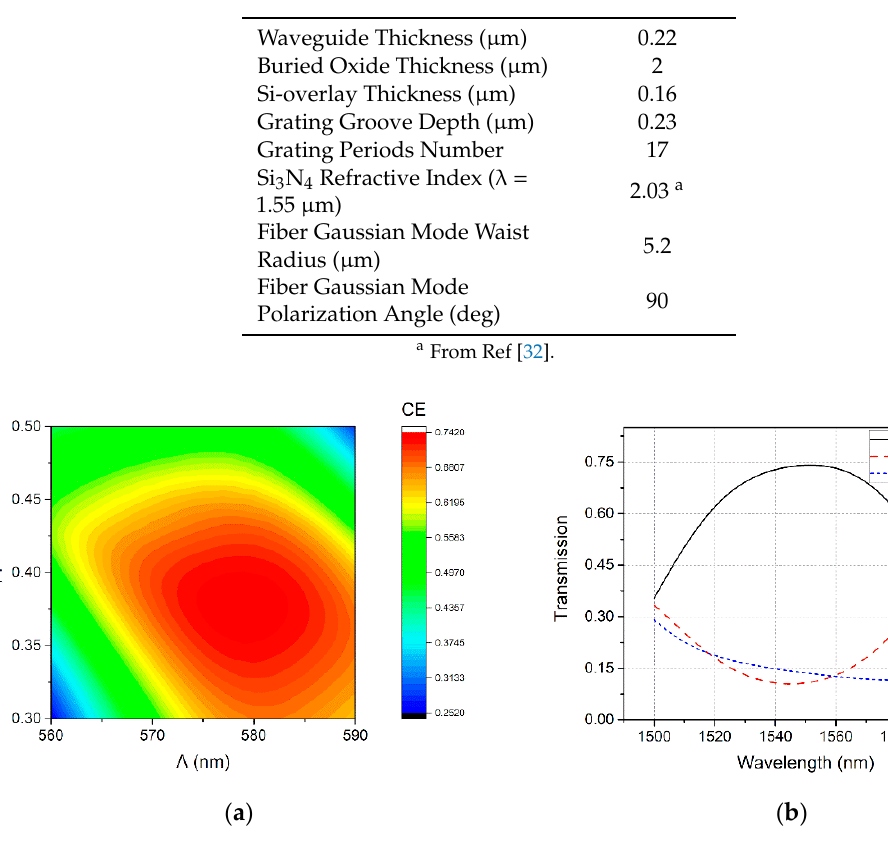
Figure 3. ( a ) The CE at 1550 nm with different Λ and filling factor (FF). The grating coupler with Λ = 578 nm and FF = 0.38 achieves CE of 74%. ( b ) Calculated transmission spectra of the Si-overlay grating coupler with Λ = 578 nm and FF = 0.38.